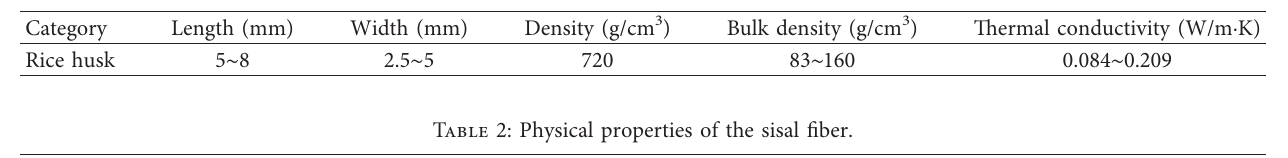
Table 1: Physical properties of the rice husk.